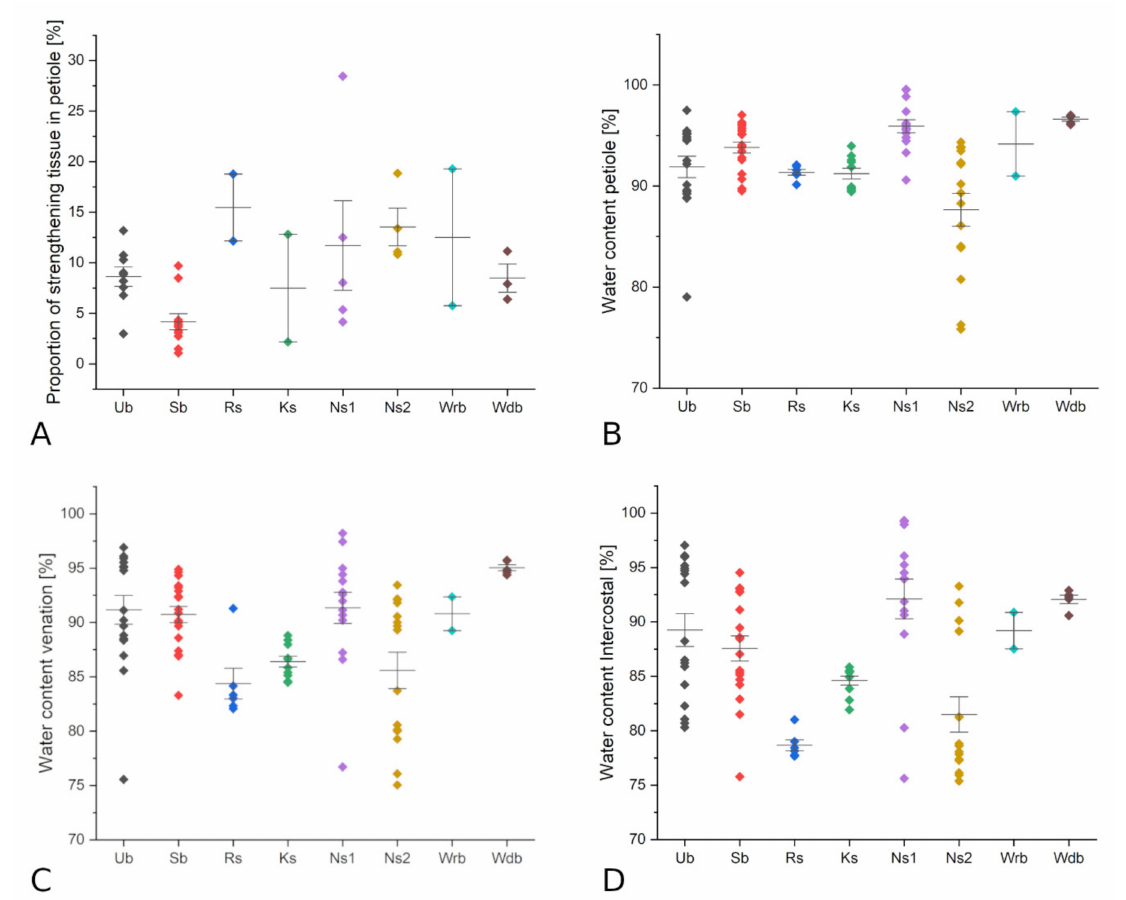
Figure 3. Proportion of (lignified) strengthening tissue in petiole ( A ) and water content of petiole ( B ), venation ( C ) and intercostal areas ( D ) in % of the different types of strengthening structures in peltate leaves (with mean and standard error). Abbreviations for strengthening structures: Ub—unbranched, Sb—simple branching, Ns1—net-like structure, intensity 1, Ns2—net-like structure, intensity 2, Ks—knot-like structure, Rs—ring-like structure, Wdb—water plant diffuse branching type, Wrb—water plant radial branching